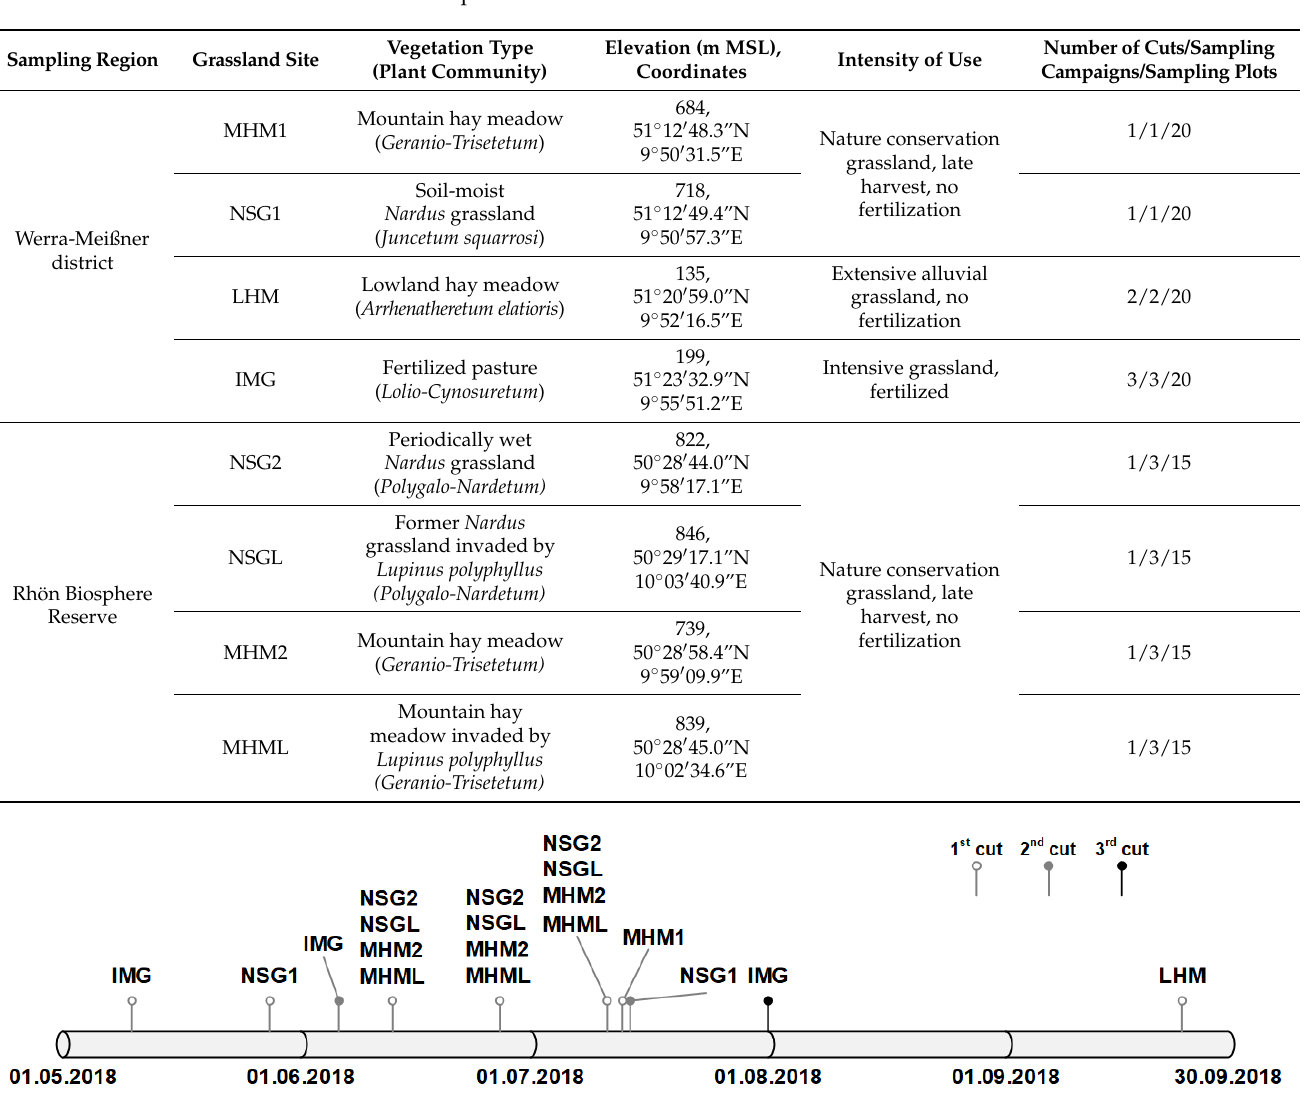
Table 1. Overview of examined grassland sites. The number of cuts and number of sampling campaigns differ, as at the sites in Rhön Biosphere Reserve, undisturbed grassland swards were harvested at multiple dates, while at the sites in Werra-Meißner-District, the same grassland sward received multiple cuts.